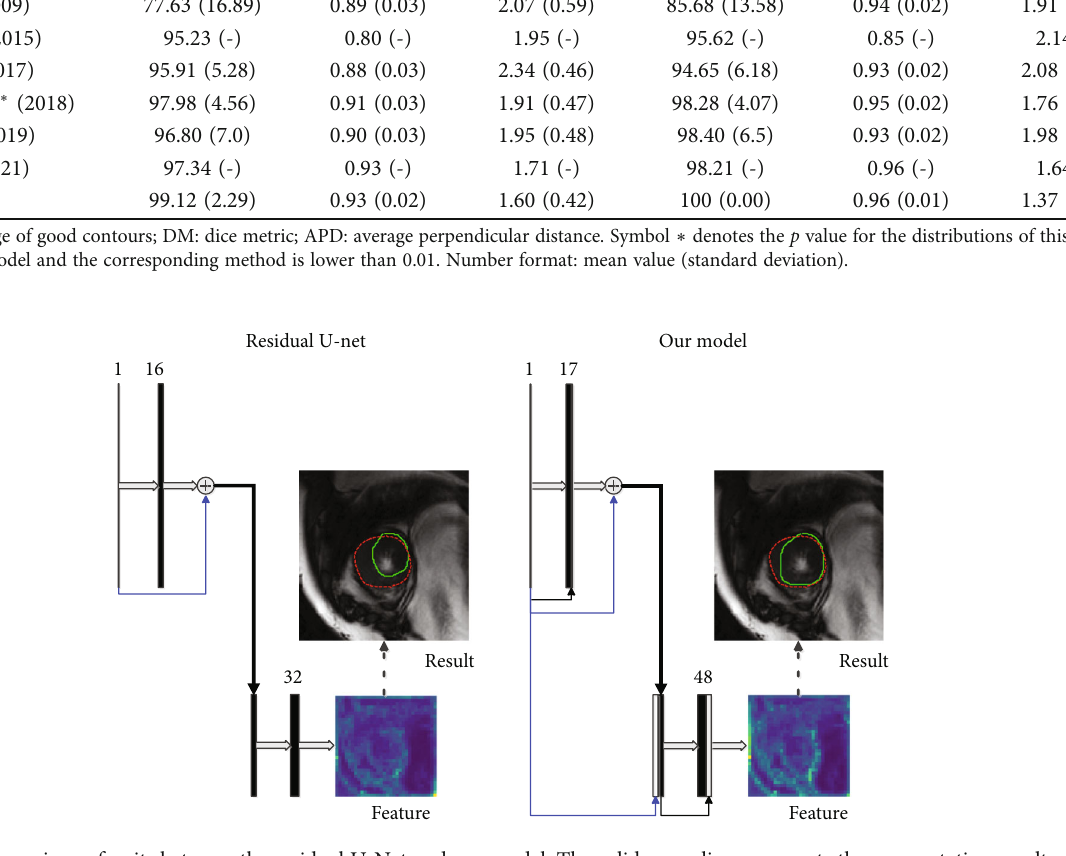
Figure 7: Comparison of units between the residual U-Net and our model. The solid green line represents the segmentation result, and the dotted red line represents the ground